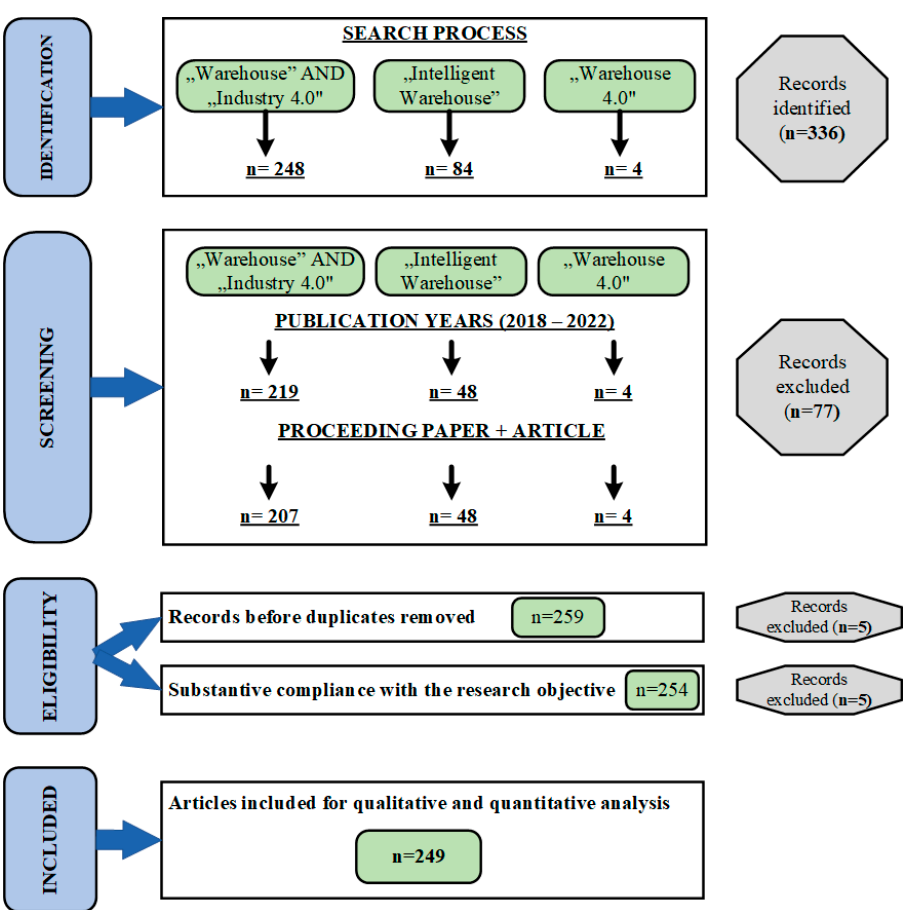
Figure 3. PRISMA—Flow diagram of the systematic selection literature in the analyzed research area.